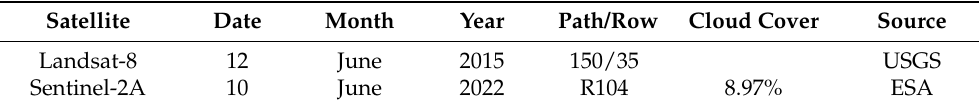
Table 1. Details of satellite images used in this study. Satellite Date Month Year Path/Row Cloud Cover Source Landsat-8 12 June 2015 150/35 USGS Sentinel-2A 10 June 2022 R104 8.97%